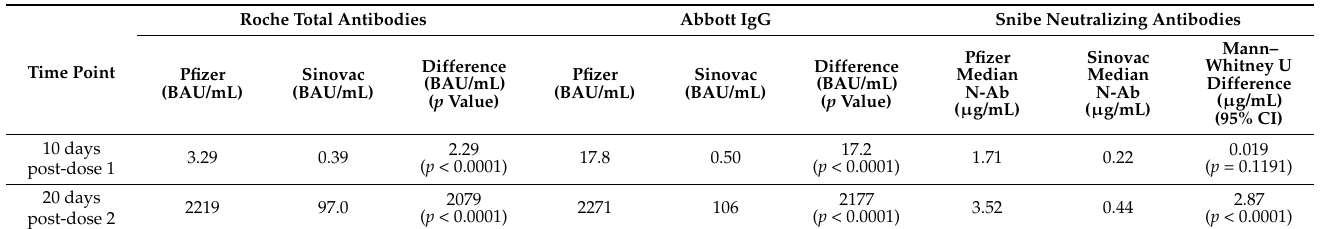
Table 2. Differences in median total, IgG and neutralizing antibodies at each time point between both groups of